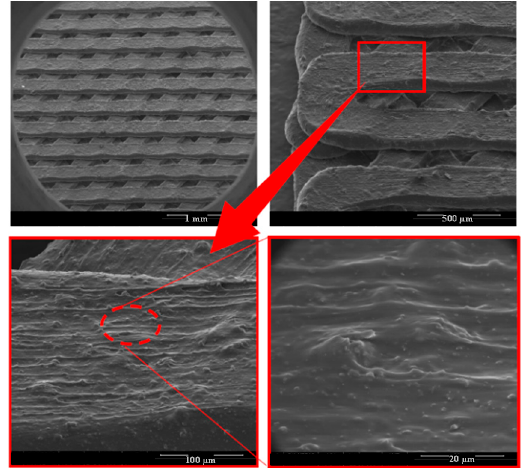
Figure 6. Scanning Electron Microscope (SEM) images of the prepared PCL/PLGA/ β -TCP membrane. SEM images showed a rough surface, which was produced by incorporating TCP powder.